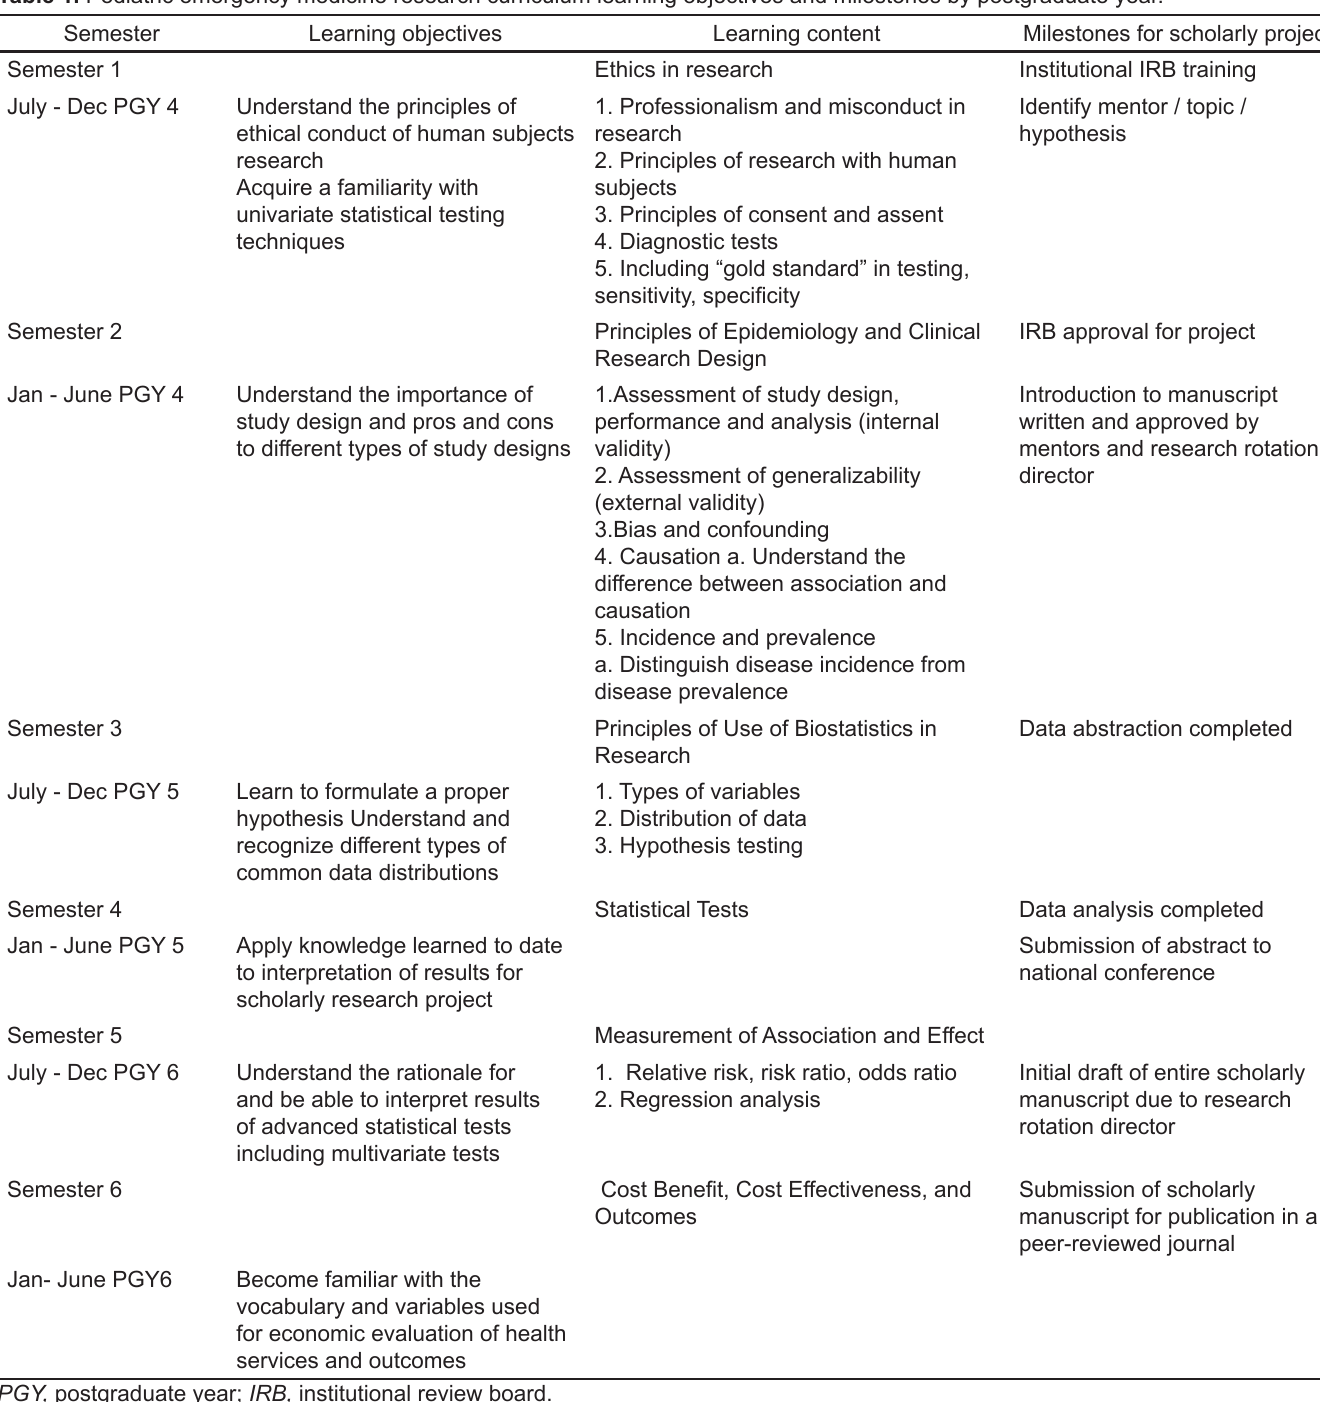
Table 1. Pediatric emergency medicine research curriculum learning objectives and milestones by postgraduate